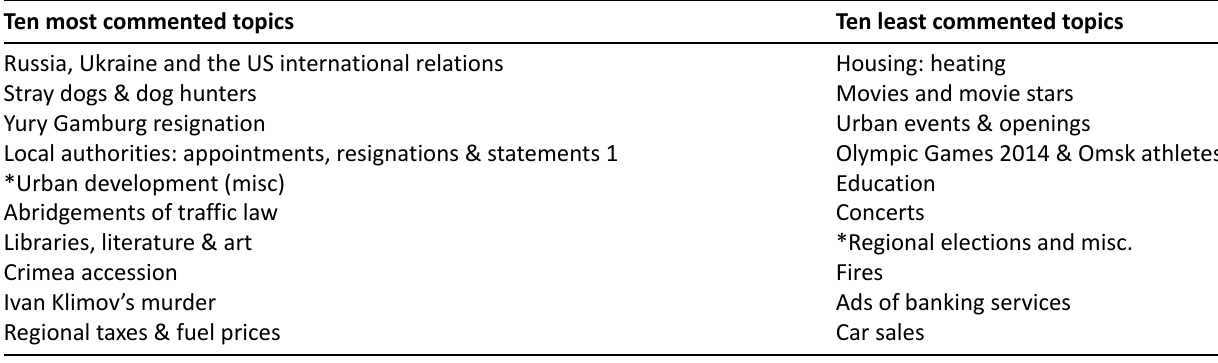
Table 2. Topic importance for readers (max = 100%; min =